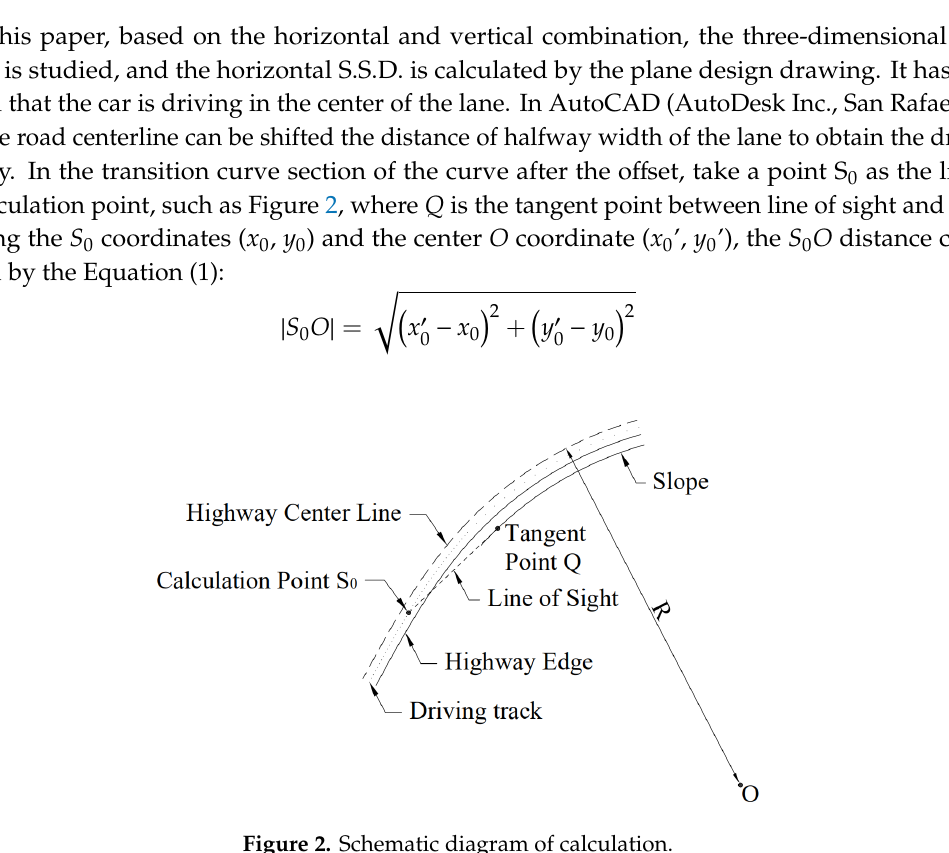
Figure 2. Schematic diagram of calculation.